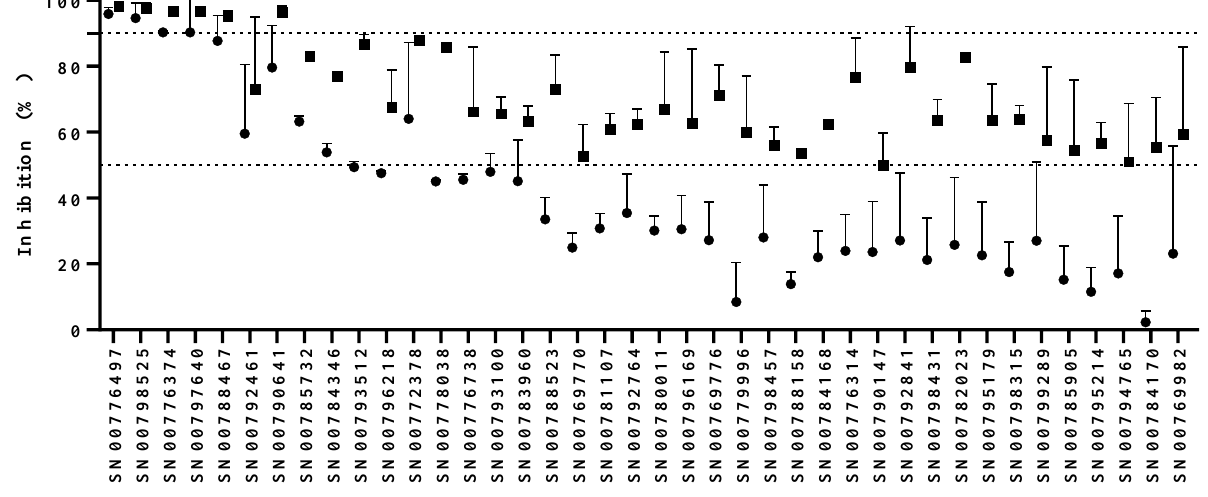
Figure 1. Anti- Giardia activity of hits identified in a sub-set screen of the Compounds Australia Scaffold Library. Compounds were tested for activity at 10 µ M for 24 h ( • ) and 48 h ( ■ ). Data are presented as mean % inhibition of trophozoite growth + SD (n = 2). Only compounds which inhibited growth by >50% (above the lower dotted line) at one or both time-points are shown. Data for all other compounds can be found in Supplementary Material, Table S1.